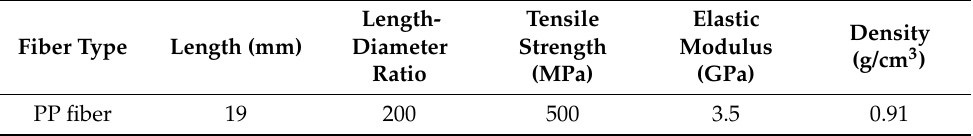
Table 3. The properties of polypropylene